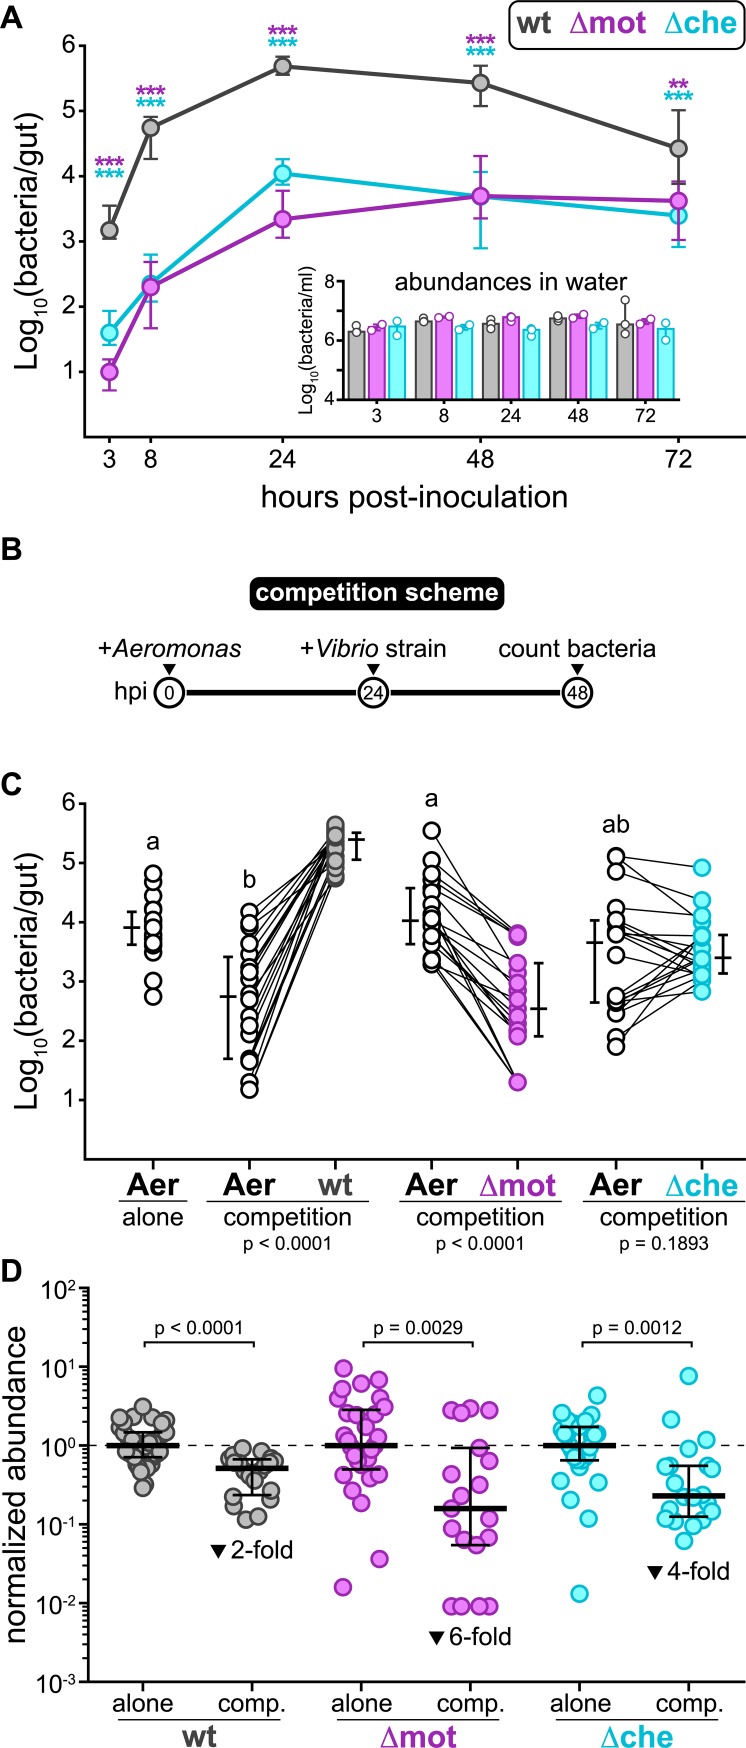
Loss of swimming motility or chemotaxis attenuates intestinal colonization and interbacterial competition.(A) Abundances of wt Vibrio, Δmot, and Δche during monoassociation. Plotted are medians and interquartile ranges (n ≥ 17 animals/marker). Significant differences between each mutant and wt Vibrio determined by Mann-Whitney (purple asterisks: Δmot; cyan asterisks: Δche). ***p < 0.0001, **p = 0.0002. Inset shows median bacterial abundances in the water environment from each replicate experiment across all time points. (B) Experimental timeline of Aeromonas–Vibrio competition. (C) Intestinal abundances of Aeromonas and wt or mutant Vibrio strains during different competition schemes. Aeromonas abundances while alone during monoassociation are shown for statistical comparison. Letters denote significant differences between Aeromonas treatments. Lines show paired Aeromonas and Vibrio abundances within individual fish. p < 0.05, Kruskal-Wallis and Dunn’s multiple comparisons test. Adjacent bars denote medians and interquartile ranges. Significant differences based on Wilcoxon between Aeromonas and each Vibrio strain are noted below each competition. (D) Abundances of wt and mutant Vibrios during competition with Aeromonas (from panel C) normalized to abundances during monoassociation at 24 hpi (from panel A). Bars denote medians and interquartile ranges. Significant differences determined by Mann-Whitney. Fold-decreases based on medians. Underlying data plotted in panels A, C, and D are provided in S1 Data. Aer, Aeromonas; hpi, hours post inoculation; wt, wild type.